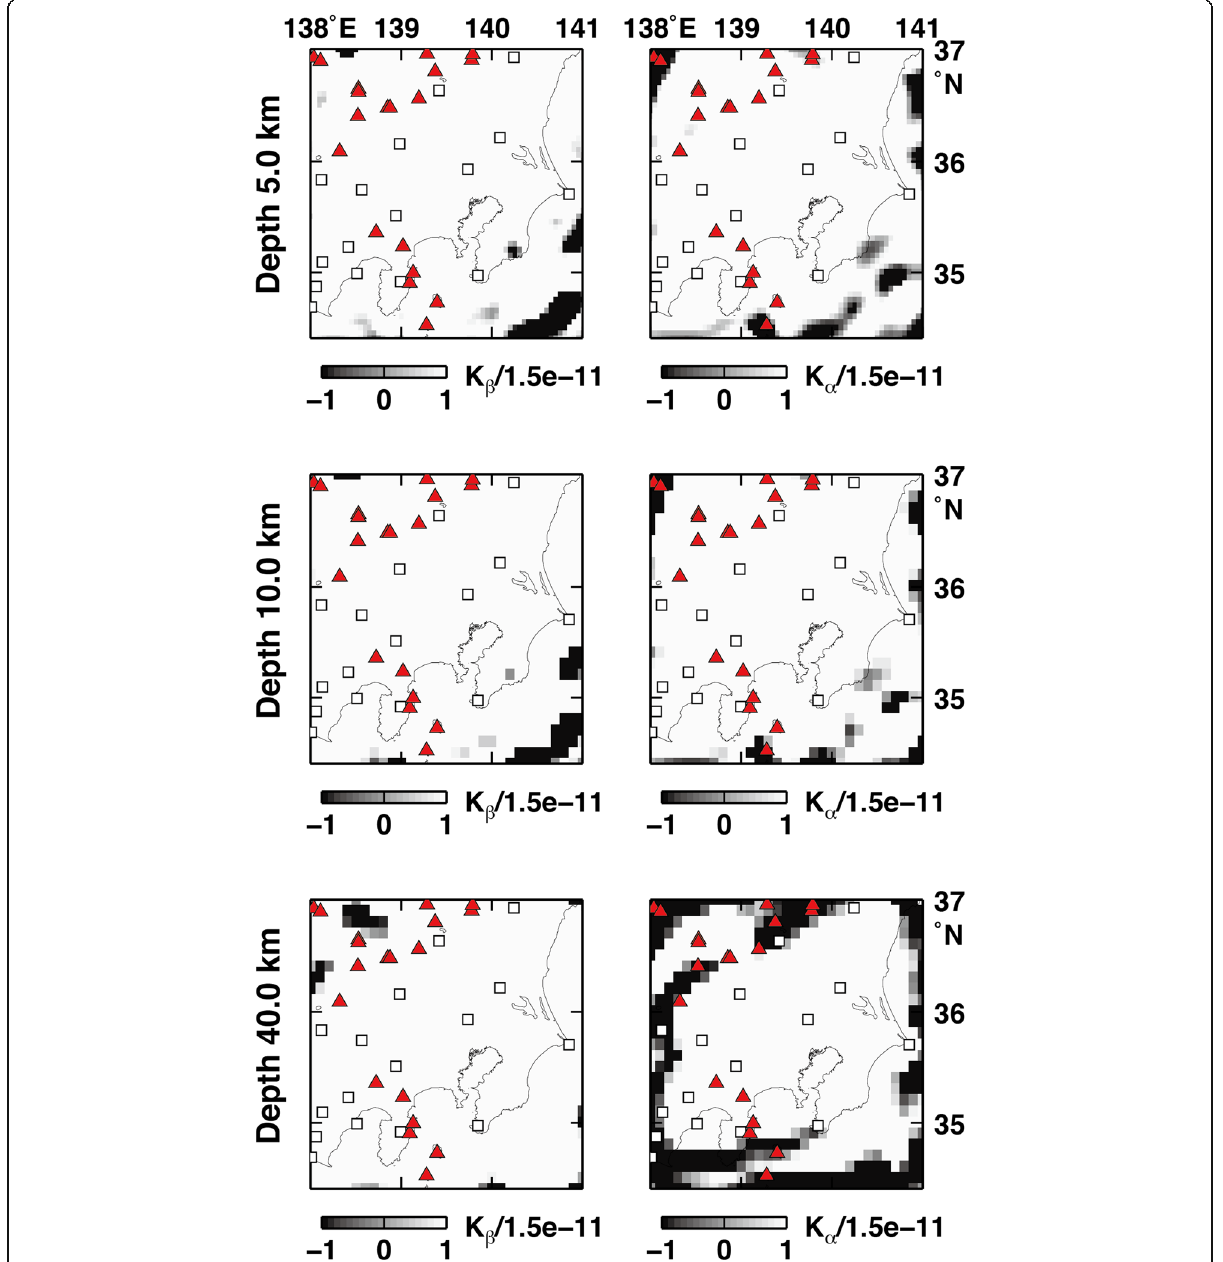
Fig. 16 Data coverage concerning seismic wave speed. The left and right figures indicate the coverage of V s and V p , respectively. The kernels were normalized by a subjective value of 1.5 × 10 − 11 . Open squares and red triangles indicate F-net stations and volcanoes,